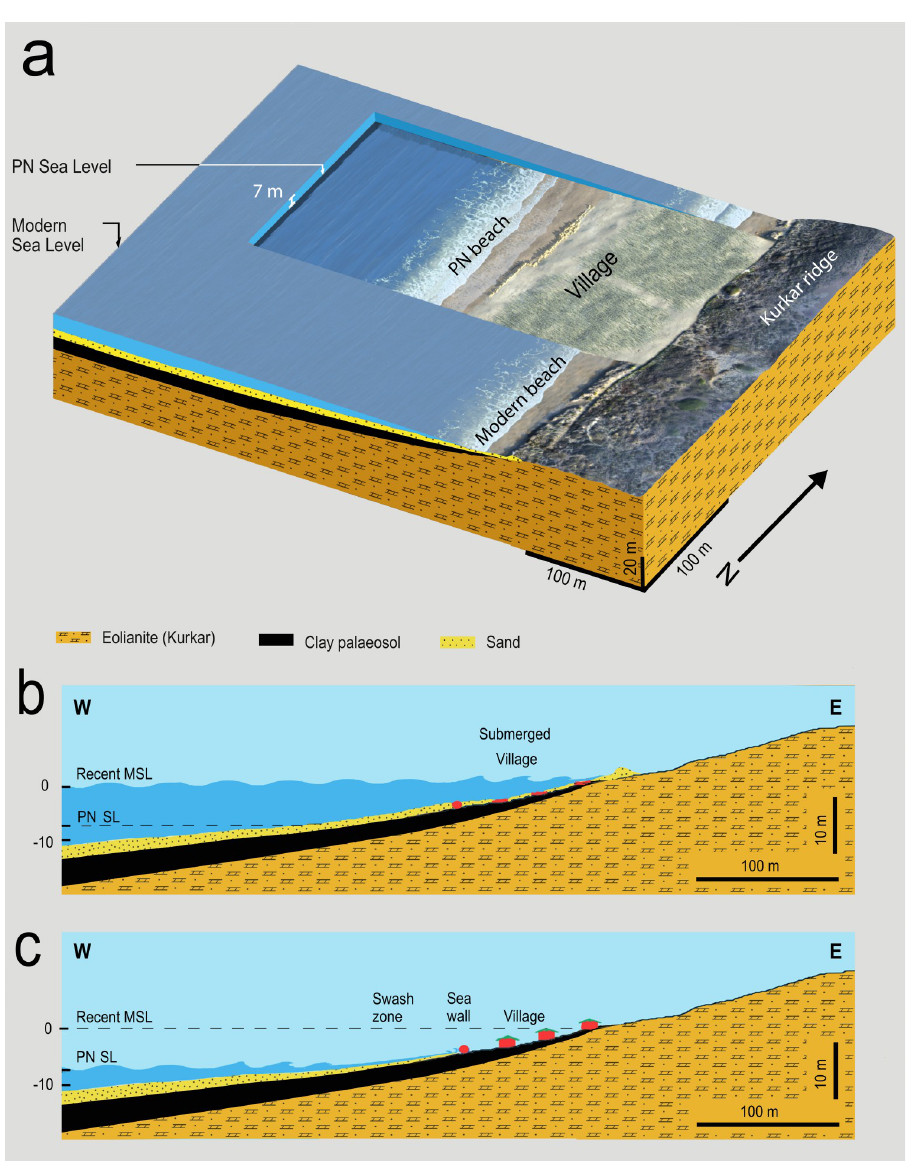
Fig 4. (a) isometric modelling of the Tel Hreiz seawall based on an aerial photograph of the site and its hinterland (b) schematic cross section of the site today, and (c) during the Pottery Neolithic period (J. McCarthy, E. Galili, and J.